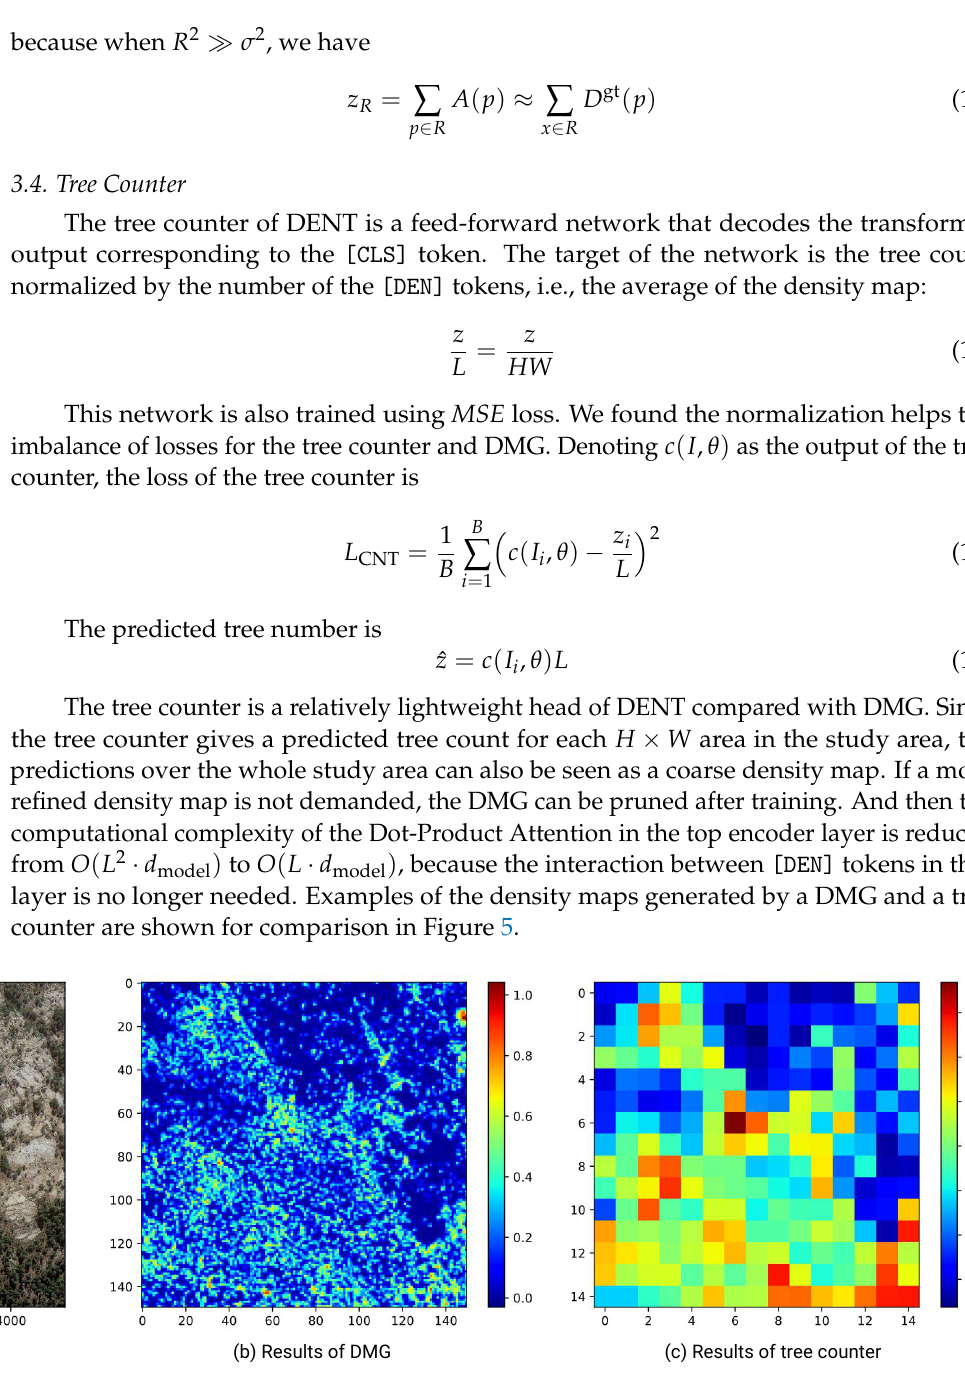
Figure 5. A comparison between the granularities of the DMG and the tree counter. ( a ) An example image from a 4800 × 4800 region, which is 566 m × 566 m in real world. ( b ) The corresponding 150 × 150 desity map generated by DMG. ( c ) The corresponding 15 × 15 coarser density map generated using the tree